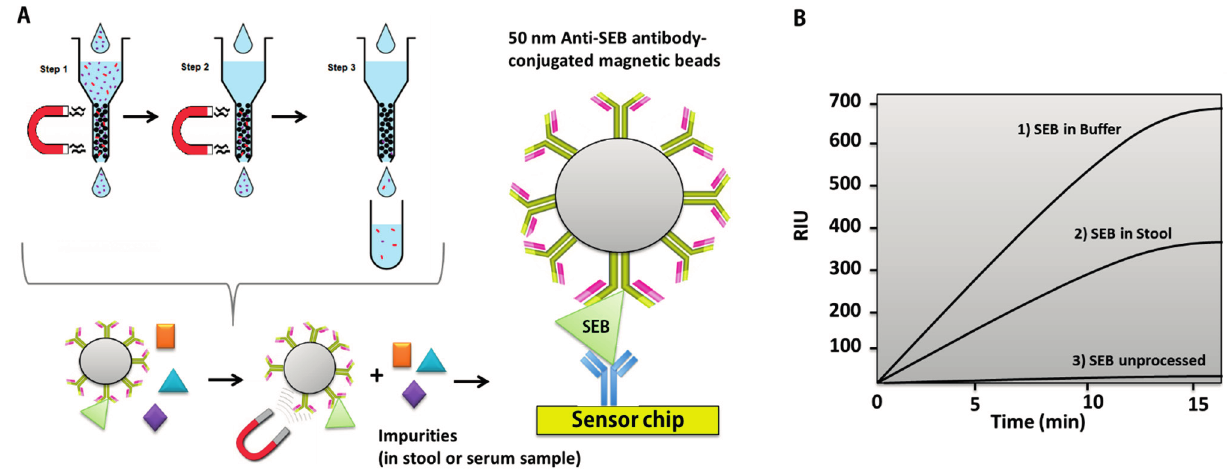
Figure 8. Strategy for detecting SEB in buffer and stool using antibody-coated magnetic nanobeads. ( A ) Steps for processing samples with colloidal immunomagnetic beads (antibody-coated superparamagnetic nanobeads). Anti-SEB antibody-modified nanobeads were mixed with solutions containing the target antigen (SEB) prior to the SPR measurement; ( B ) SPR detection of staphylococcal enterotoxin B (SEB) in buffer (663 RIU), in stool (365 RIU), and unprocessed (7 RIU). Adapted from